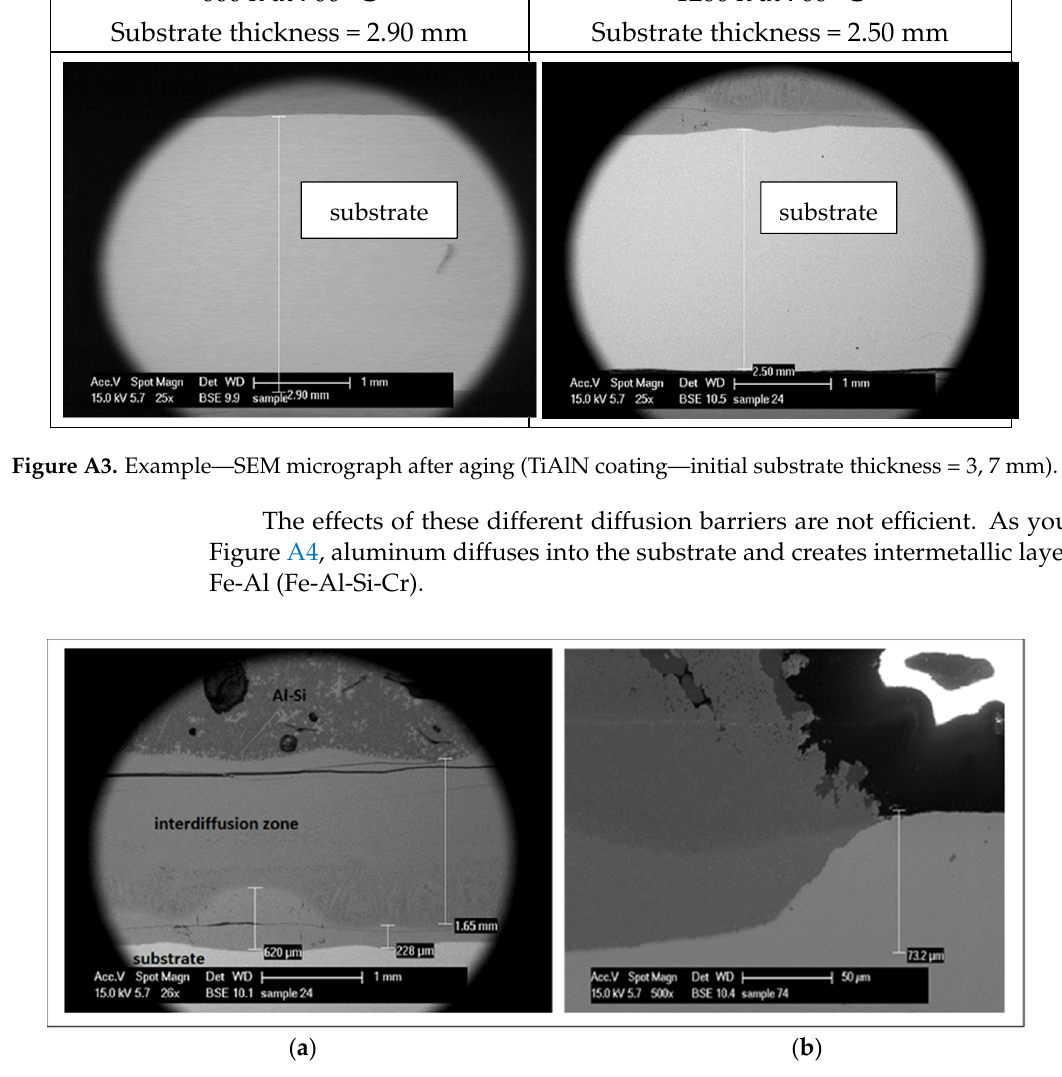
Figure A4. SEM micrograph. ( a ) Thickness of the intermetallic layers after 1200 h of aging with a TiAlN coating. ( b ) Diffusion of aluminum at some points—bad durability of the coating based on boron nitride.